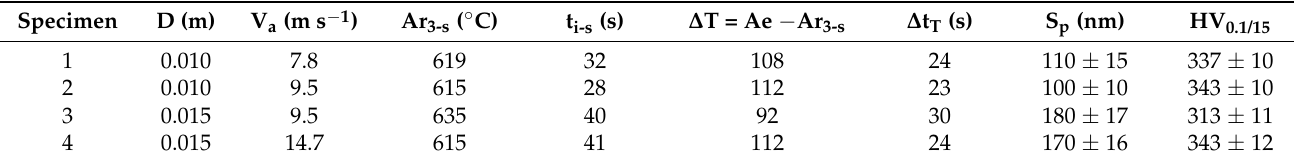
Table 3. Microstructural parameters for the analyzed cooling conditions.